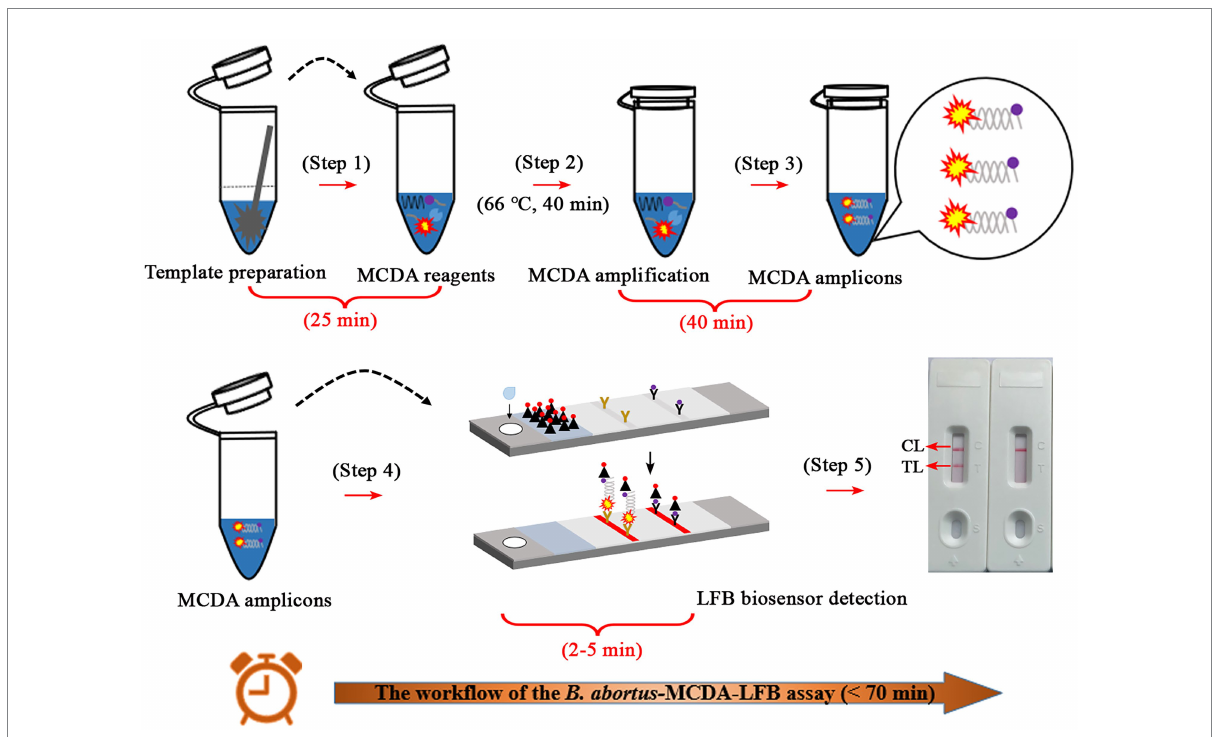
FIGURE 2 Description of the detection workflow of the B. abortus -MCDA-LFB assay. The detection workflow of the B. abortus -MCDA assay mainly consists of three steps: the DNA templates were rapidly prepared ( step 1 ), the reaction tubes premixed with DNA template, amplification reagents, and MCDA primers were incubated at 66 ° C for 40 min ( steps 2 and 3 ), and then the amplicons were verified using the AuNPs-LFB biosensor ( steps 4 and 5 ). Finally, the entire workflow of the B. abortus -MCDA-LFB assay for whole blood samples can be completed within 70 min, including DNA template preparation (25 min), MCDA amplification (40 min), and AuNPs-LFB biosensor validation (2–5 min). MCDA, multiple cross displacement amplification; AuNPs-LFB, gold nanoparticles-based lateral flow biosensor; TL, test line; CL, control